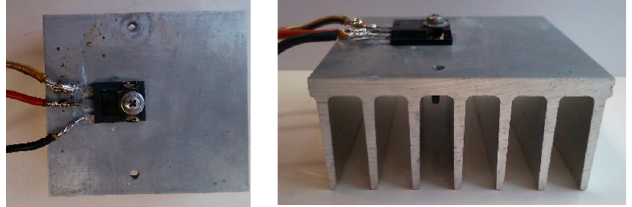
Figure 3. View of the tested device situated on the heat-sink.